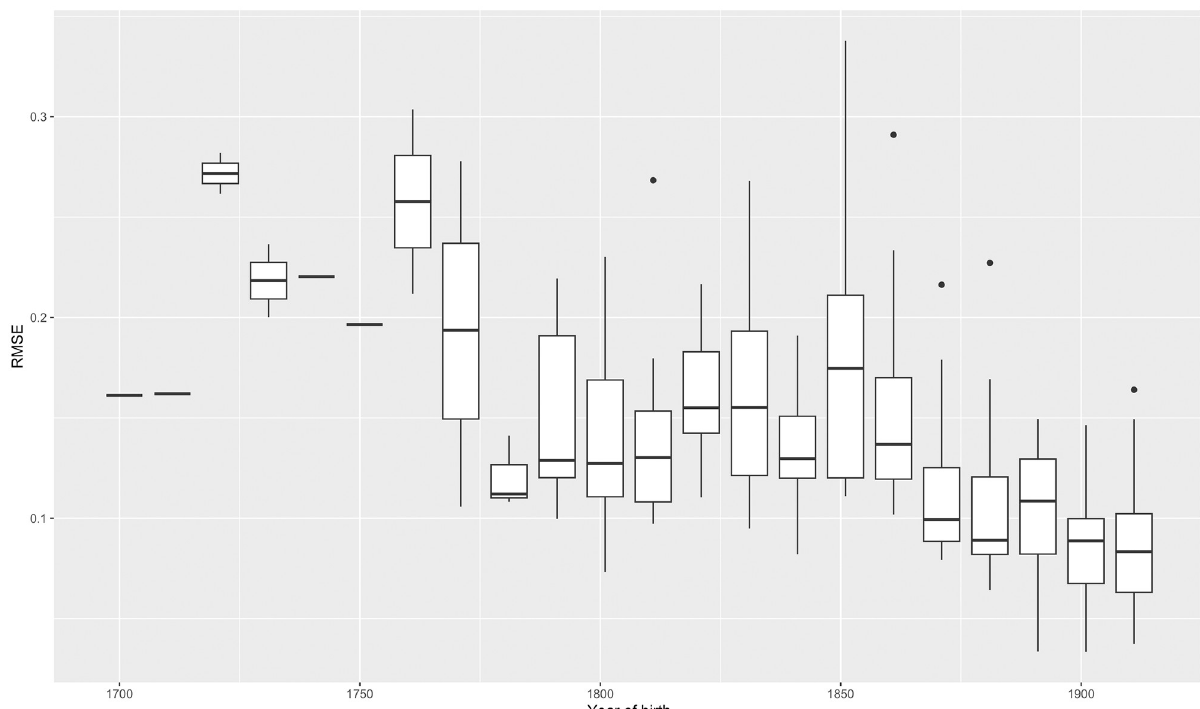
Fig 4. Box-and-whisker plot of the distribution of the RMSE across extinct cohorts, by decade of birth.